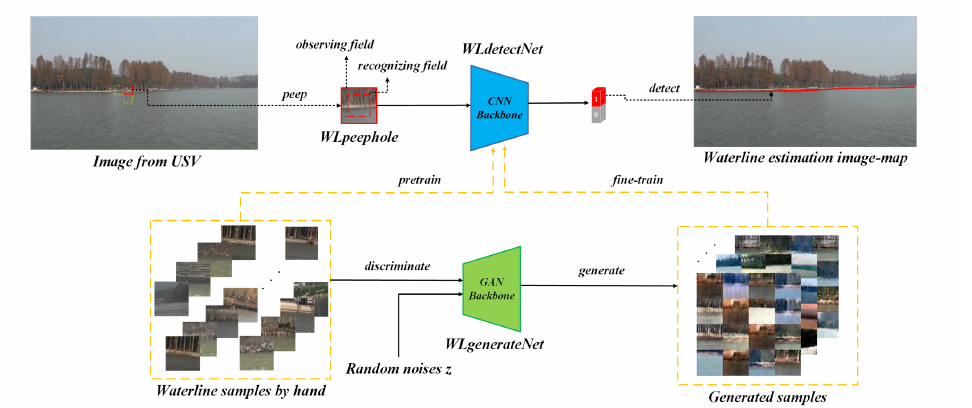
Figure 1. The diagram of our proposed DeepWL for waterline